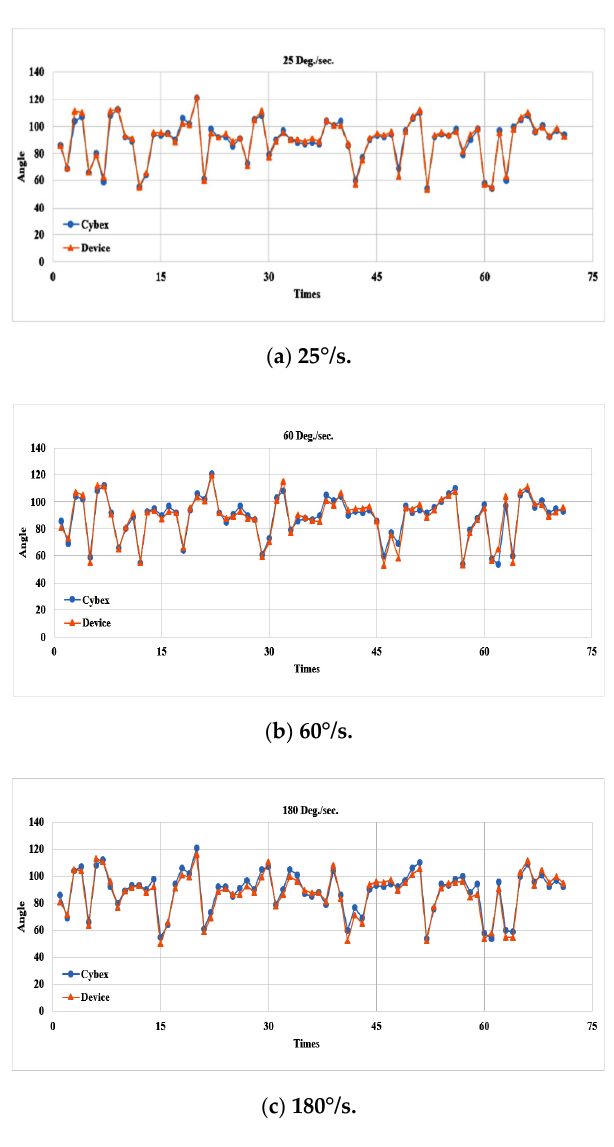
Figure 16. Comparisons of ROM for TKR subjects at three speeds.